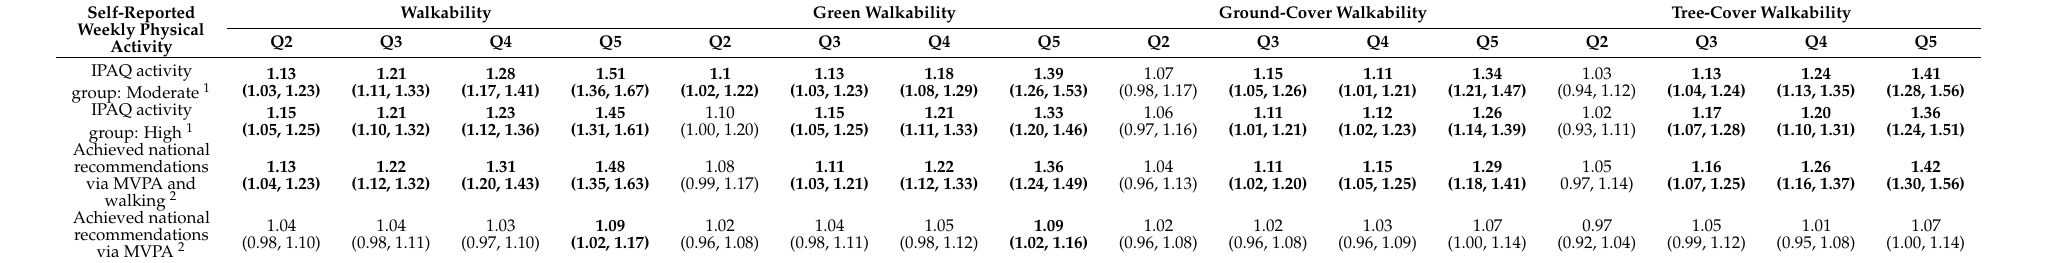
Table 2. Odds (risk ratio) and 95% confidence intervals (CIs) of high and moderate compared low physical activity levels based on self-reported International Physical Activity Questionnaire (IPAQ) responses by quintiles of walkability (Q1 is the lowest 20% of walkability across participants’ addresses and is used as reference category; Q5 represents the highest 20% of walkability) ( n = 57,726). Walkability, green walkability, ground-cover walkability and tree-cover walkability were assessed as the independent (exposure) variable in separate models ( n = 57,726 for all models). Odds and 95% confidence intervals of achieving UK physical activity guidelines (150 MET minutes per week) based on MVPA only, and MVPA and walking, by quintiles of walkability, green walkability, ground-cover walkability and tree-cover walkability are also shown. All models are adjusted for: age, sex, average household income before tax, and area-level deprivation. Bold font indicates p ≤ 0.05.